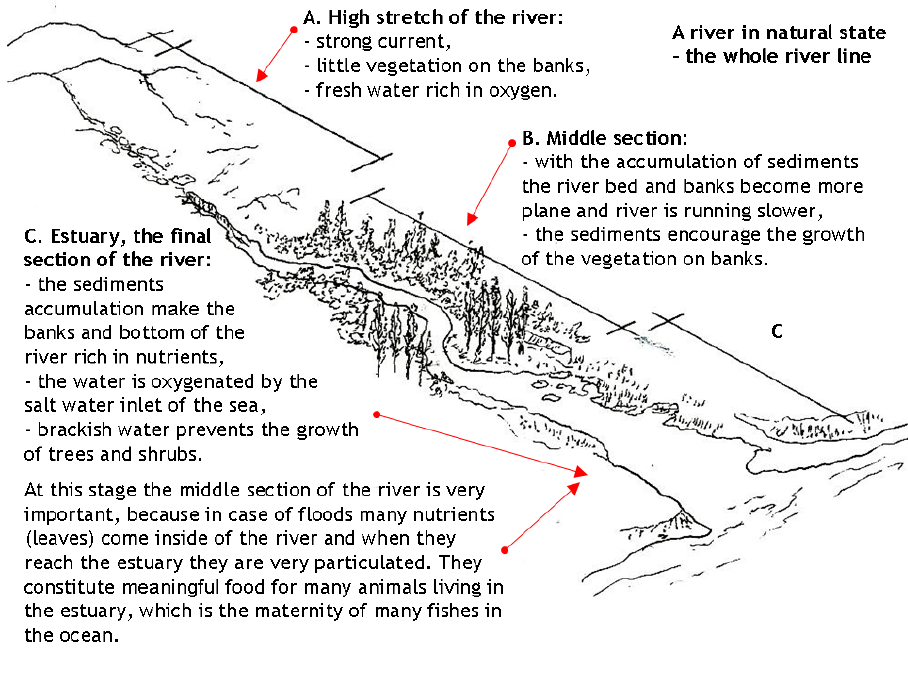
Figure 2a: The natural flow of river, showing the total appearance of the river banks. Here its three parts: A,B, and C. The article focuses on the part B, which is presented in the paper in the detailed process of its life (nature, “domestic” degradation, degradation by “moderniza- tion”/ artificialization, and finally renaturalization). The riparian gallery is important to maintain the temperature of the water. “Tempera- ture, for instance, limits the growth and reproduction of all organisms. Different organisms tolerate different ranges of temperature” [8]. Certain plants on river banks provide free ecological services, for example they filter toxic wastes and pollutants, absorb and excess water from storms, and provide habitats for many species [9].